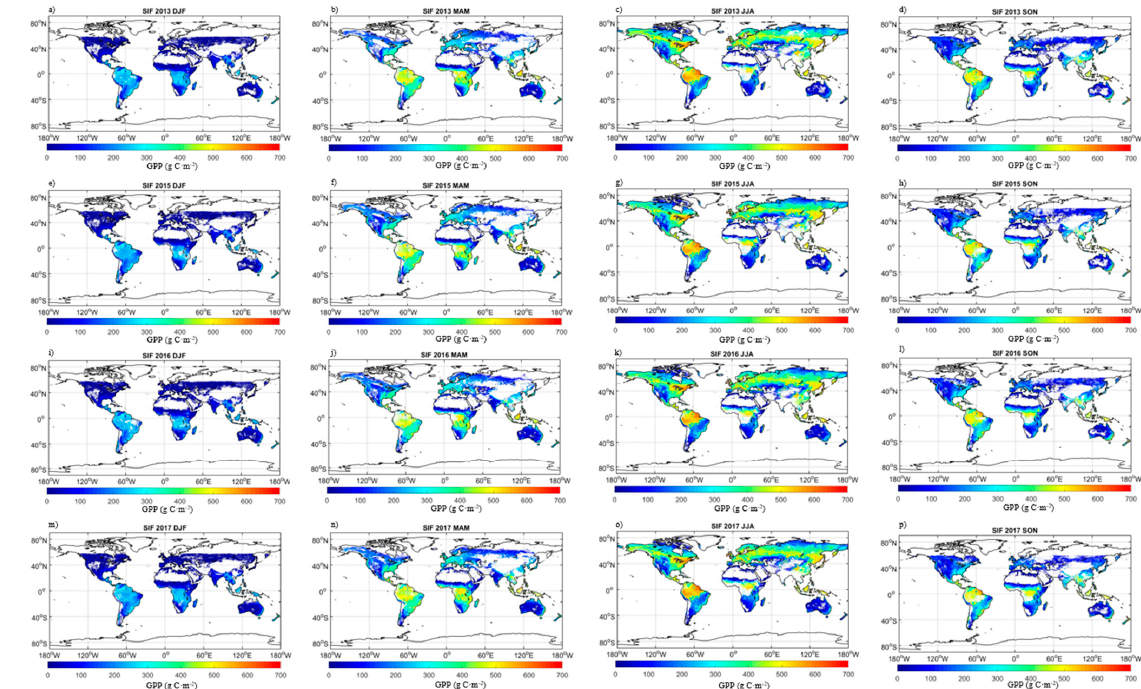
Figure A4. Spatial patterns of global GPP in different seasons: ( a ) GPP SIF in DJF of 2013; ( b ) GPP SIF in MAM of 2013; ( c ) GPP SIF in JJA of 2013; ( d ) GPP SIF in SON of 2013; ( e ) GPP SIF in DJF of 2015; ( f ) GPP SIF in MAM of 2015; ( g ) GPP SIF in JJA of 2015; ( h ) GPP SIF in SON of 2015; ( i ) GPP SIF in DJF of 2016; ( j ) GPP SIF in MAM of 2016; ( k ) GPP SIF in JJA of 2016; ( l ) GPP SIF in SON of 2016; ( m ) GPP SIF in DJF of 2017; ( n ) GPP SIF in MAM of 2017; ( o ) GPP SIF in JJA of 2017; ( p ) GPP SIF in SON of 2017.